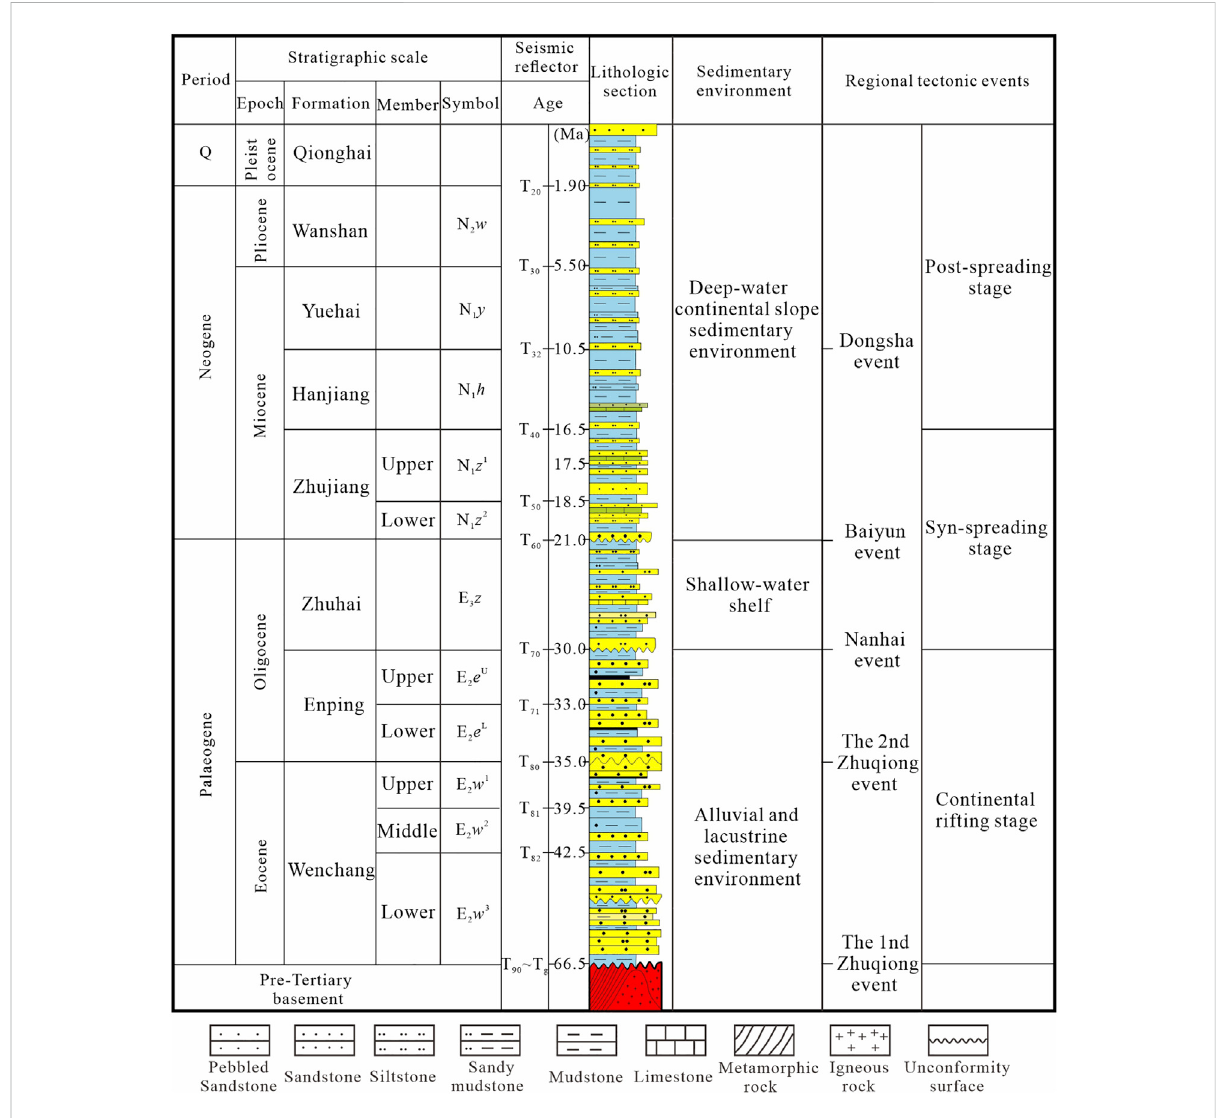
FIGURE 3 ComprehensivestratigraphiccolumnofthePRMBshowingmajortectonicanddepositional events(modi fi edafterLiHetal.,2014;ZhuWetal., 2009; Zhu et al., 2021; Zhang et al.,